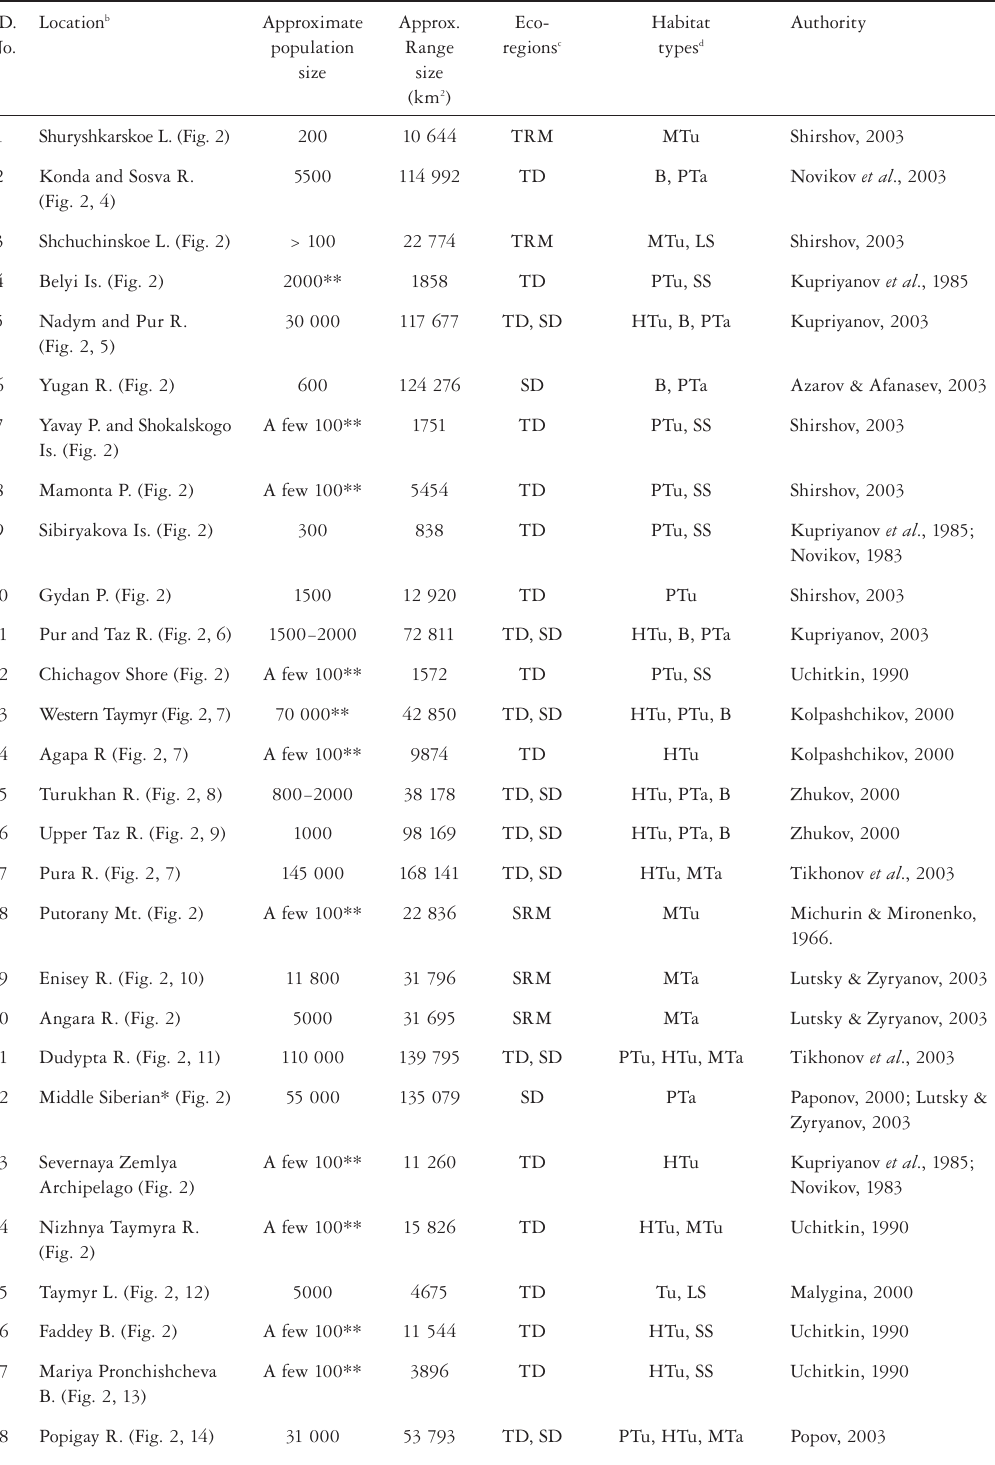
Table 1. Inventory of 87 wild and feral reindeer populations identified in Siberia and the Far East of Russia, 2006 a . I.D. Location b Approximate No.